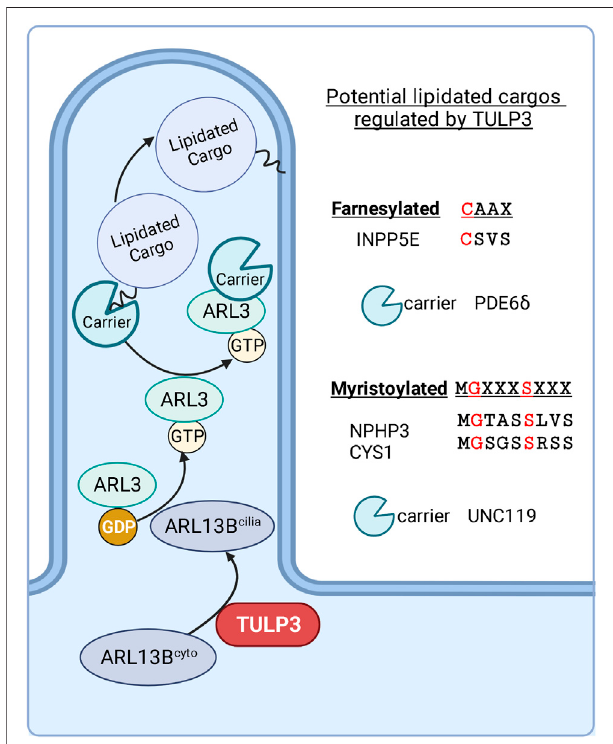
FIGURE 6 | Potential lipidated cargoes of TULP3. TULP3 directs the traf fi cking of ARL13B to cilia. ARL13B regulates the release of farnesylated and myristoylated cargoes in the ciliary compartment via ARL3. Created in